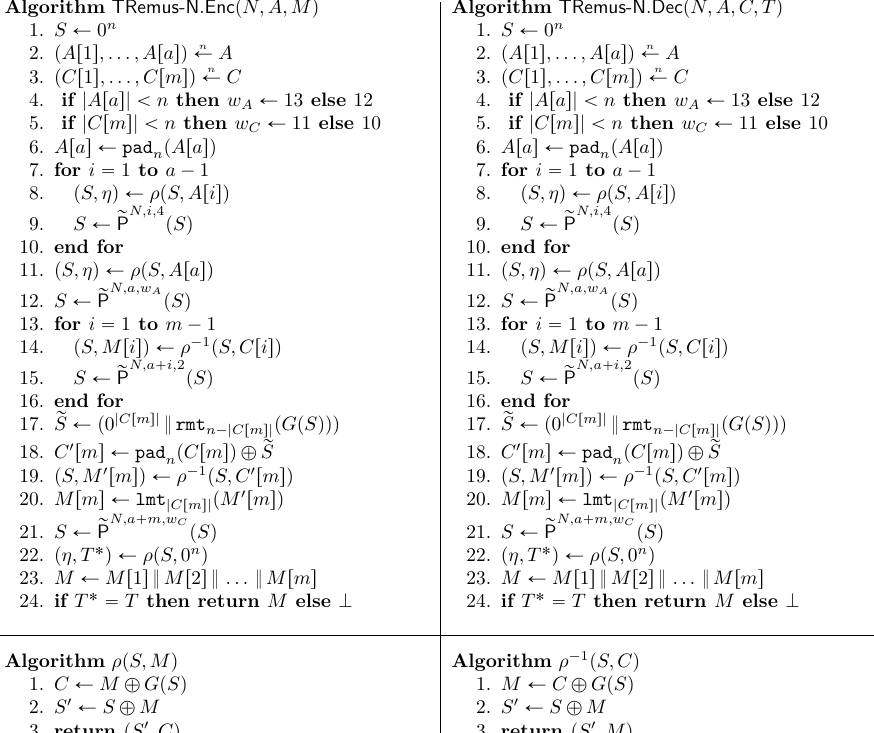
Figure 14: A TBC-based abstraction of Remus-N . Here the TBC is a TURP the same I/O as GICE1 and GICE2 . Lines of [if (statement) then X Ð x else x 1 ] are shorthand for [if (statement) then X Ð x else X Ð x 1 ] . The dummy variable η is always discarded. As an example, this abstracts Romulus - N 1. In fact ρ has been redefined in the proof so that it directly accepts the final partial block and does padding internally (see Preliminaries at the beginning of this